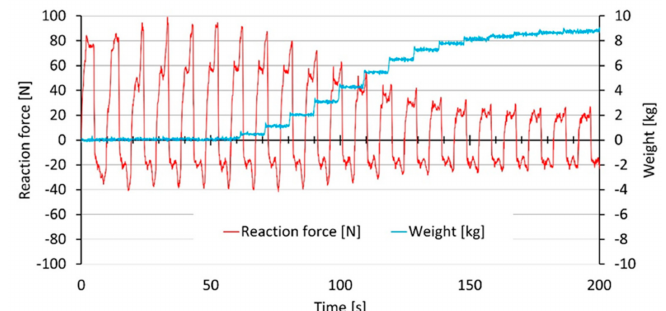
Figure 7. Reaction force acting on the driving mechanism at the 30% level of shifting speed for the transported abrasive material, STEEL GRIT GH50, and depending on gradual feeding of the conveyor with 10 kg of the abrasive material.